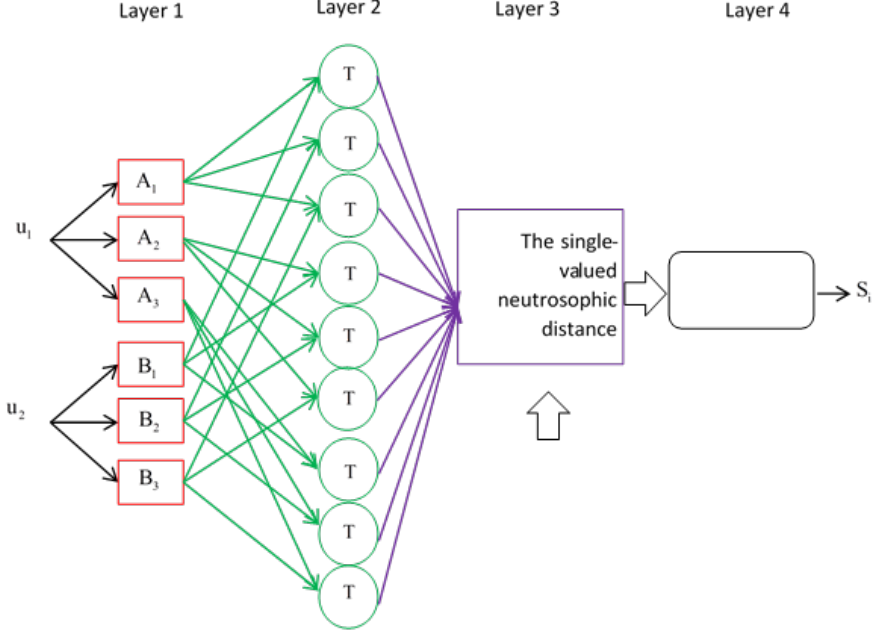
Fig. 3. The proposed ANPFIS decision making